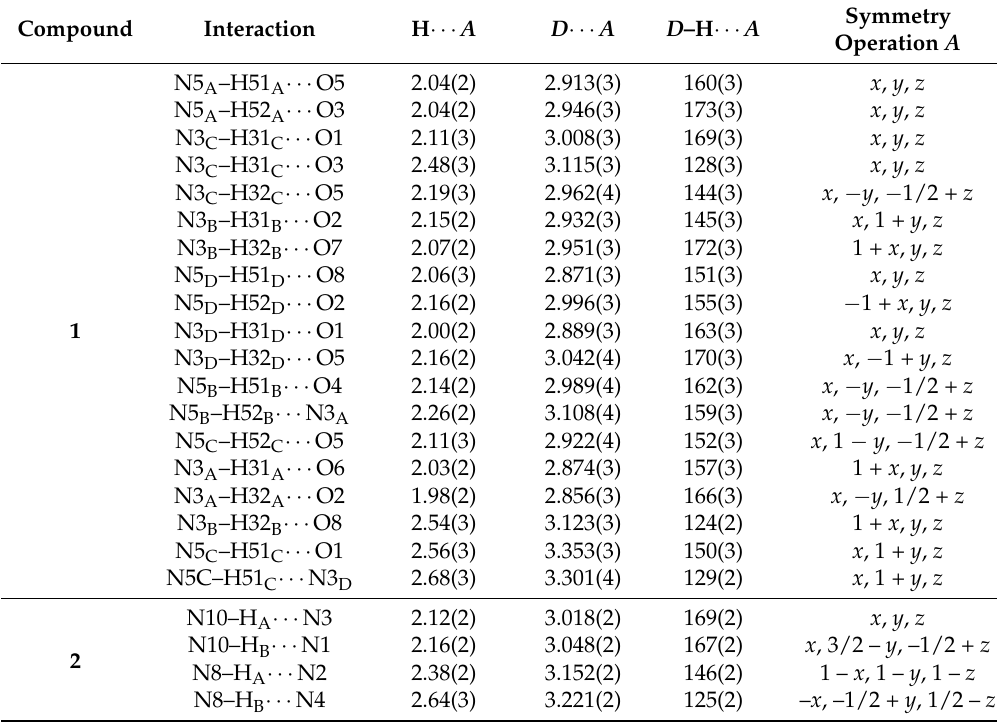
Table 2. Hydrogen bond geometry for 1 and 2 (Å, ˝